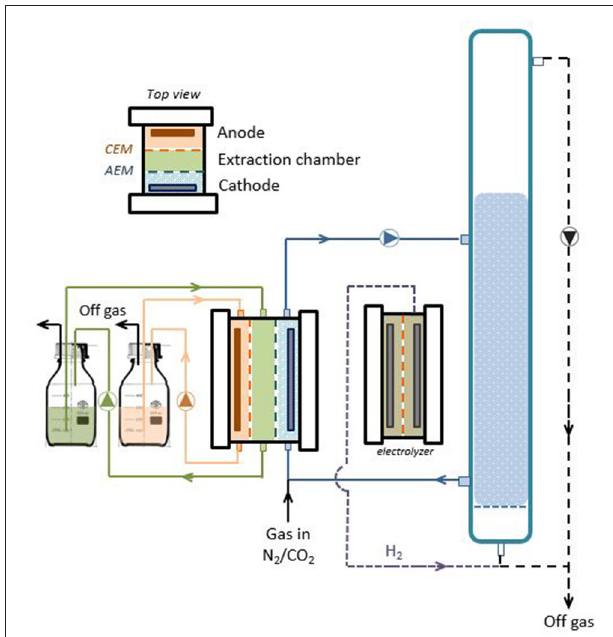
FIGURE 1 | Bubble column reactor setup for simultaneous biological production and extraction of acetic acid from CO 2 and electrical current through a hybrid microbial electrosynthesis-gas fermentation approach. An external fermenter is fed with additional hydrogen from a water electrolyzer to increase acetate production rates. Full black lines show liquid streams, dotted lines gas